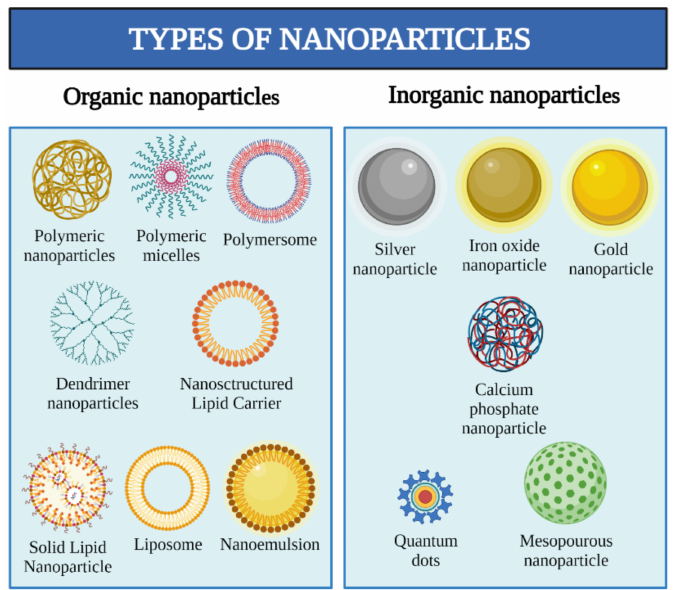
Figure 1. Types of nanoparticles according to their main